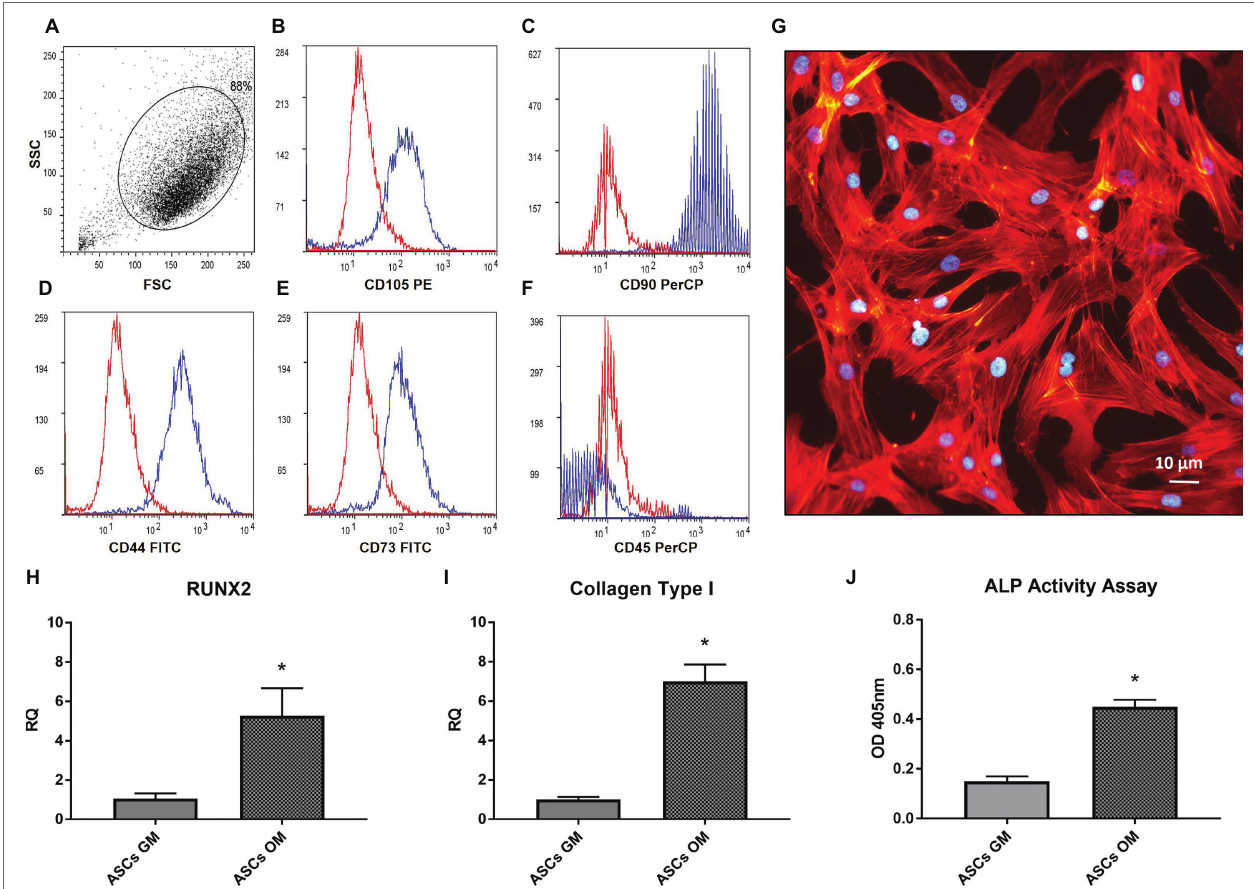
FIGURE 1 | Characterization adipose-derived stem cells. (A–F) Flow cytometer analysis performed on in vitro cultured ASCs; the expression of CD105, CD44, CD90, CD73 (B–E) and the absence of CD45 (F) is shown. (G) Morphology of isolated ASCs, stained by phalloidin(red) and Dapi (Blue). (H,I) Real-time PCR analysis of RUNX2 and Coll-I expression in ASCs after 7 days of culture in osteogenic medium (OM) or growth medium (GM). Data represent mean ± SEM. * p < 0.05. (J) Alkaline phosphatase (ALP) activity in ASCs after 7 days of culture in OM or